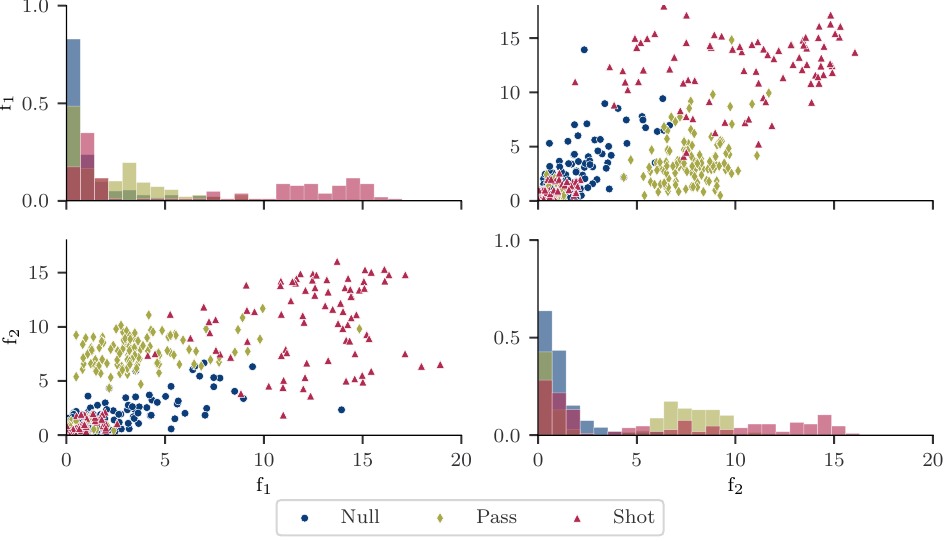
Figure 3. Histograms and scatter plots for two exemplary features: The absolute sum of the accelerometer x-axis during the kick phase (f 1 ) and the absolute sum of the accelerometer y-axis during the kick phase (f 2 ). Only shots, medial passes and light ball contacts from 2 random laboratory training sessions are considered. The histograms are constructed with 25 bins and show frequency density. In addition, the sum of the bars of each histogram is normalized and bars for different classes are